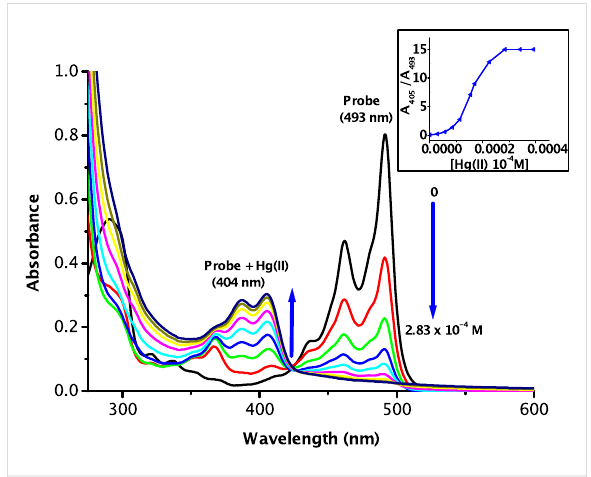
Figure 1: Spectrophotometric titration of acrithion 2 (2.83 × 10 − 5 M) with Hg 2+ (0–2.83 × 10 − 4 M) in DMSO–H 2 O (70:30 v/v) at pH